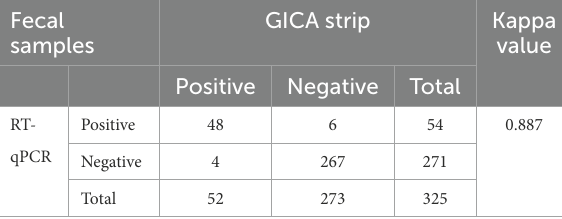
TABLE 3 Comparison of RT-qPCR and the GICA strip for detecting PDCoV in fecal samples. Fecal